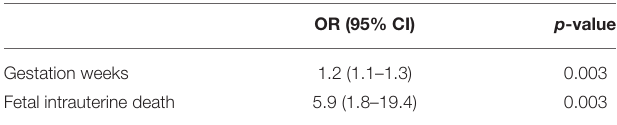
TABLE 4 | Multivariable logistic regression for